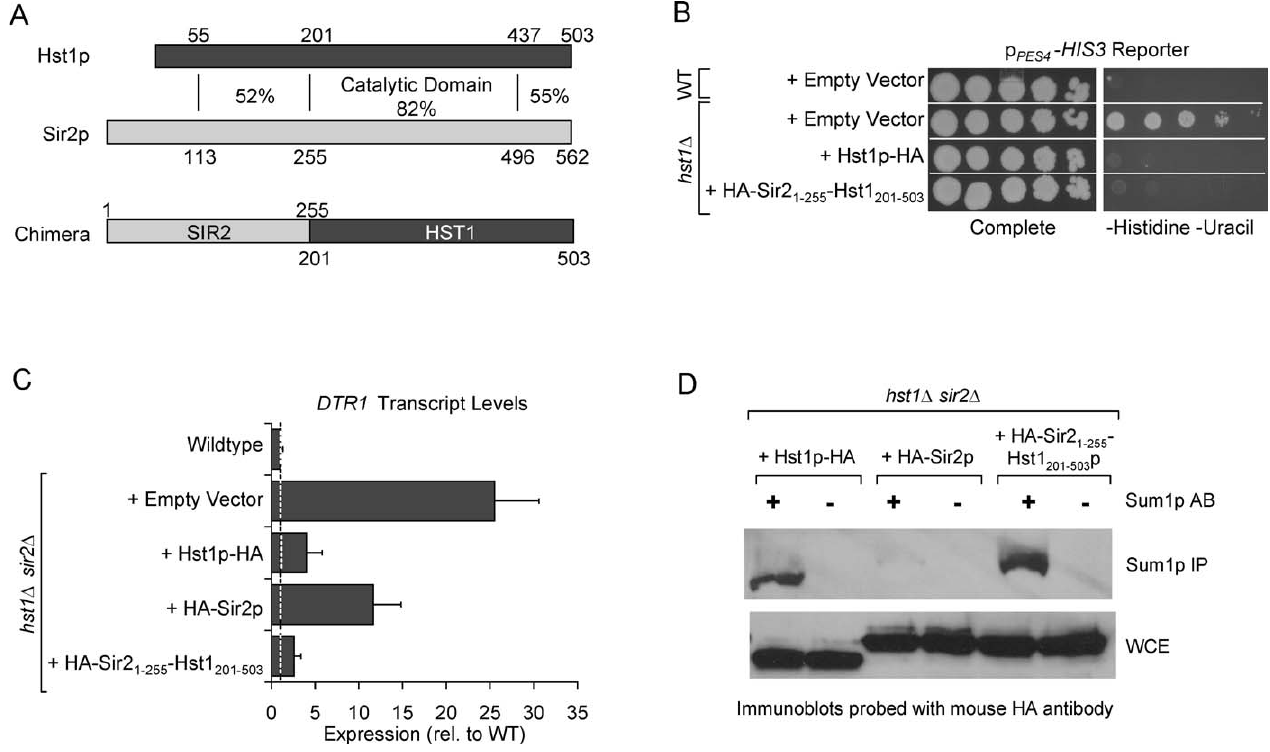
Figure 6. The Sir2 1 (cid:2) 255 -Hst1 201 (cid:2) 503 p Chimera Functions like Hst1p (A) A schematic overview of conserved domains of Sir2p and Hst1p (adapted from [28]) and the architecture of the Sir2 1 (cid:2) 255 -Hst1 201 (cid:2) 503 p chimera are shown. (B) The p PES4 -HIS3 reporter was used to assay repression by the HA-Sir2 1 (cid:2) 255 -Hst1 201 (cid:2) 503 p chimera (pLR488) and Hst1p-HA (pRO298) in a hst1 D strain (LRY1545). A ten-fold dilution series of each strain was plated on rich medium and medium lacking histidine and uracil (to maintain plasmid) and photographed after 3 d growth at 30 8 C. (C) DTR1 gene expression was assessed by RT-PCR for hst1 D sir2 D (LRY333) cells transformed with an empty vector (pRS416), HST1 -HA (pLR30), HA- SIR2 (pRO298), or HA-Sir2 1 (cid:2) 255 -Hst1 201 (cid:2) 503 (pLR488). Reported values are relative to wild-type (W303-1a) cells. (D) The association of HA-Sir2 1 (cid:2) 255 -Hst1 201 (cid:2) 503 p, HA-Sir2p, and Hst1p-HA with Sum1p was assessed by co-immunoprecipitation. Sum1p was immunoprecipitated from whole-cell extracts from the same strains used in (C), and the precipitated material was examined by immunoblotting with an a -mouse HA antibody to detect Hst1p-HA, HA-Sir2p, or HA-Sir2 1 (cid:2) 255 -Hst1 201 (cid:2) 503 p.